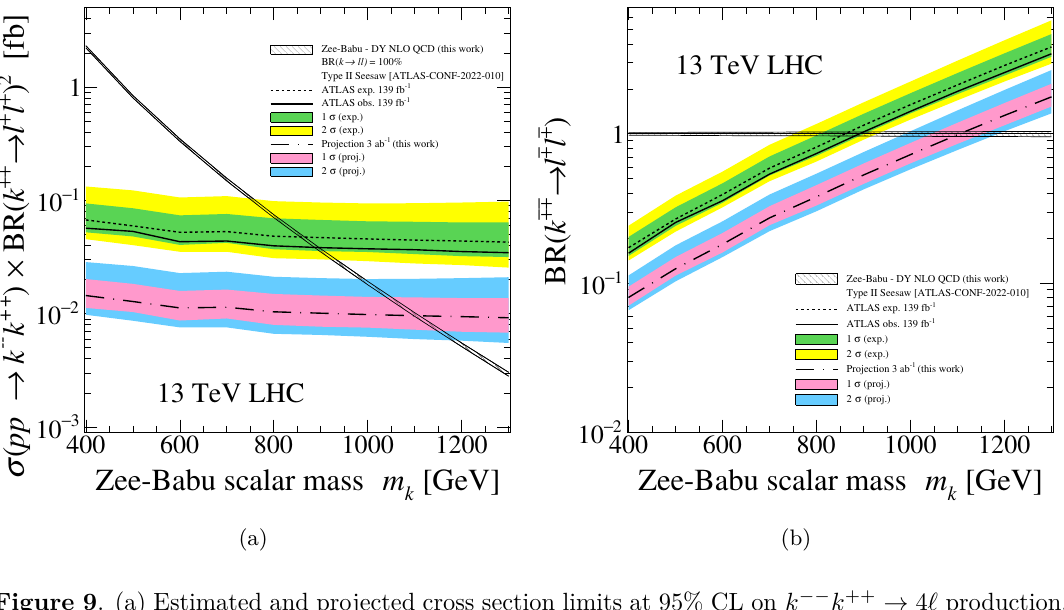
Figure 9 . (a) Estimated and projected cross section limits at 95% CL on k −− k ++ → 4 ‘ production, √ ‘ ∈ { e, µ } , in the Zee-Babu model at the s = 13 TeV LHC with L ≈ 139 fb − 1 and L ≈ 3 ab − 1 of data, respectively, as derived from constraints on ∆ ++ ∆ −− → 4 ‘ production in the Type II Seesaw by the ATLAS experiment with L ≈ 139 fb − 1 [51]. (b) Same as (a) but for the k ∓∓ → ‘ ∓ ‘ 0∓ branching